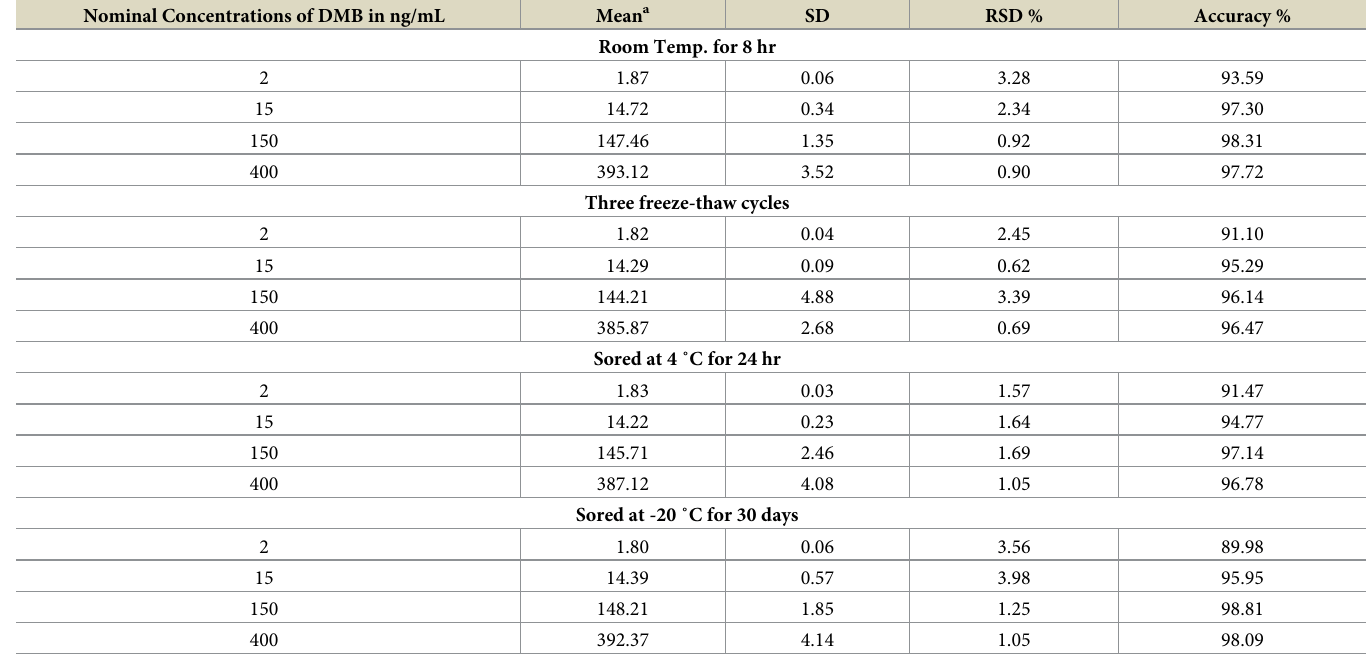
Table 4. Stability of dacomitinib (DMB) under different storage conditions. Nominal Concentrations of DMB in